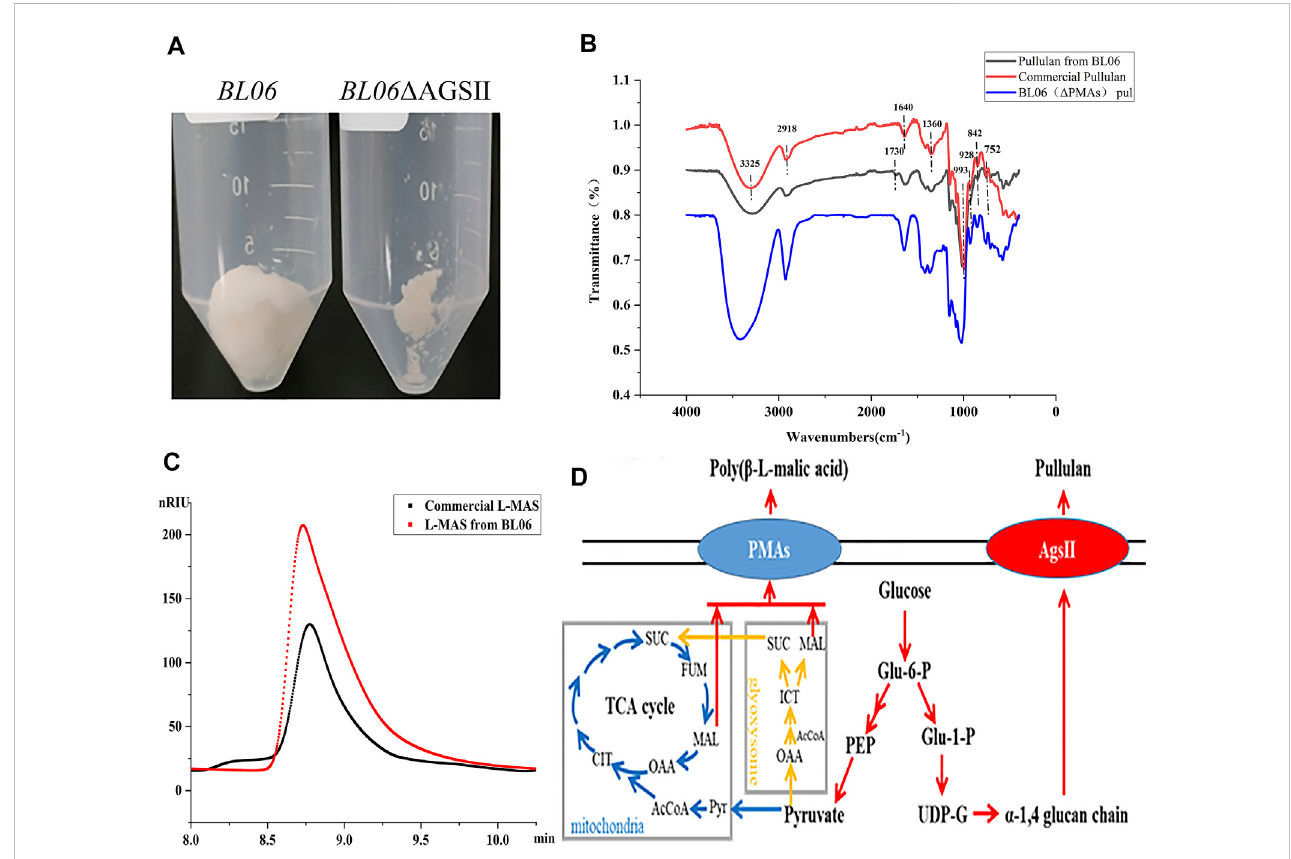
FIGURE 2 Identi fi cation and properties of the EPS of A. pullulans BL06. (A) The puri fi ed EPS produced by A. pullulans BL06 and A. pullulans BL06 Δ AGSII; (B) FTIR spectra of the puri fi ed EPS and standard pullulan; (C) HPLC analysis of the hydrolysate of the puri fi ed EPS produced by A. pullulans BL06 Δ AGSII and L-malic acid standard. (D) Synthetic pathways of pullulan and polymalic acid in A. pullulans